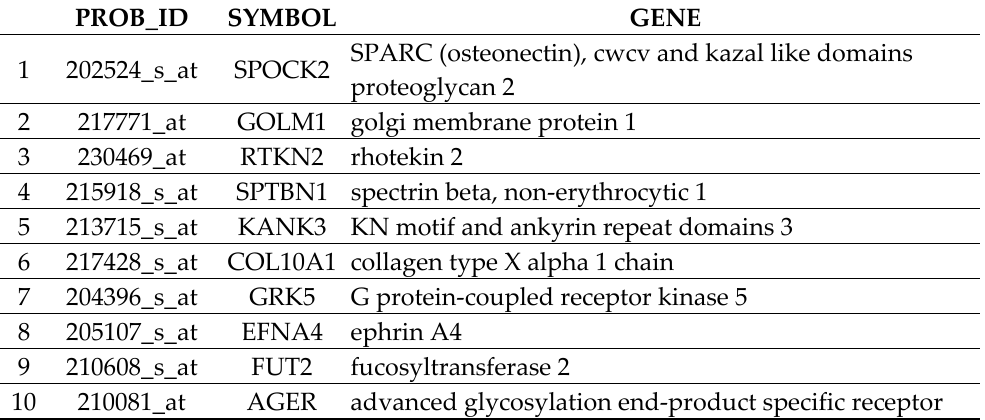
Table 2. Table of top 10 candidate differentially expressed genes identified with SVM